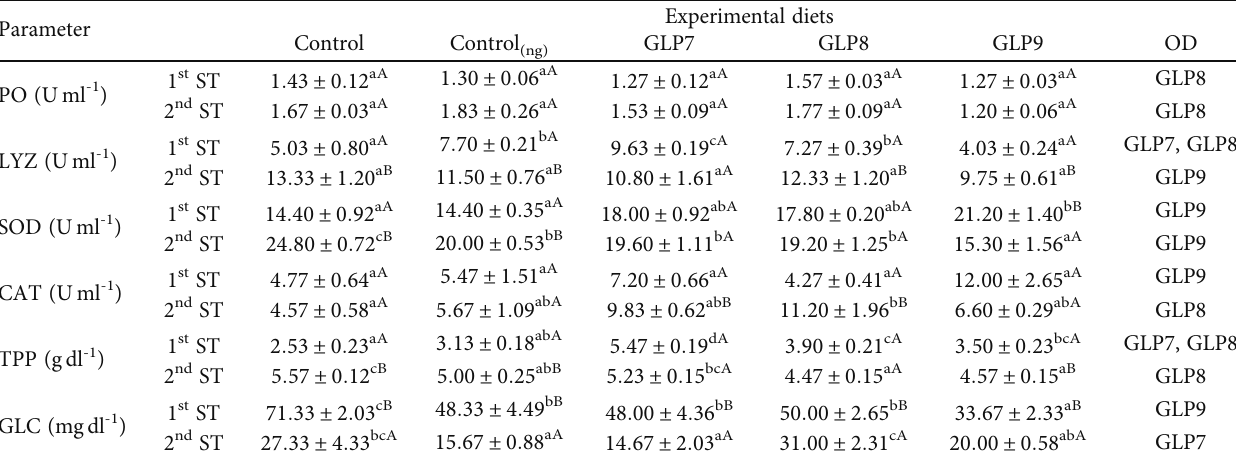
Table 4: Some innate immune parameters of narrow-clawed cray fi sh fed with di ff erent experimental diets after 97 days of feeding trials (1 st